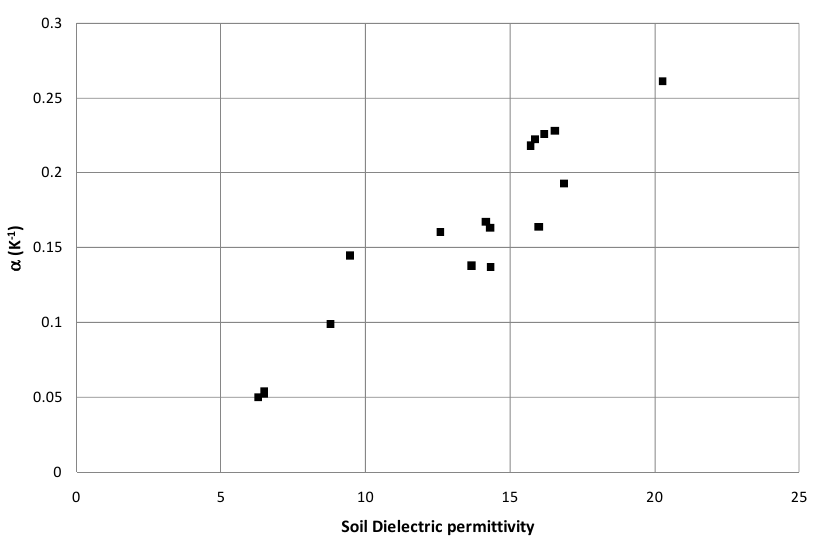
Figure 7. Temperature Sensitivity coefficient α as a function of the soil dielectric permittivity obtained with the DECAGON EC-10 probe installed at 2.5 cm depth at the INRA-Avignon observatory. Measurements were taken during the bare soil period of the sequence 2 with the sensor P3 (Table